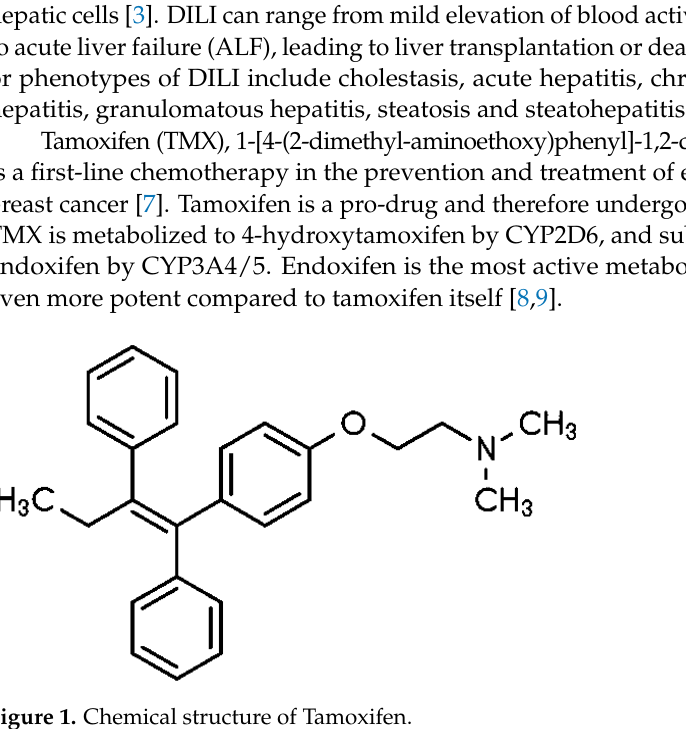
Figure 1. Chemical structure of Tamoxifen.